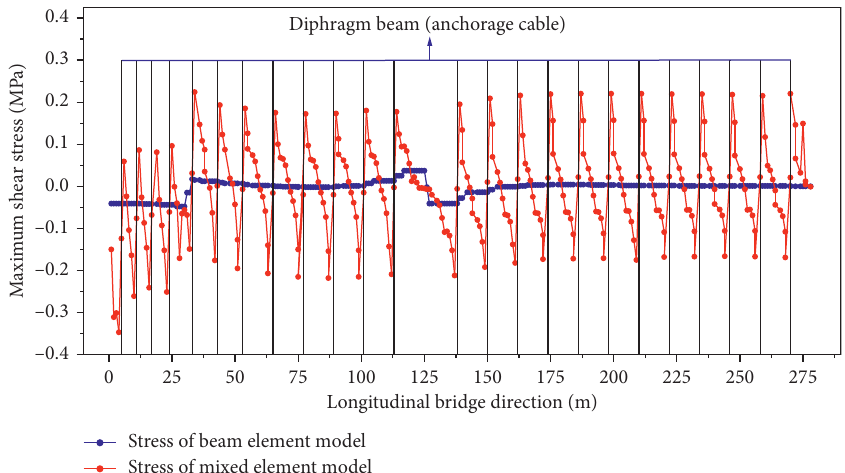
Figure 23: The maximum shear stress of the interface between the concrete deck and the steel boxes corresponding to each segment of the main girder at 15 o’clock.